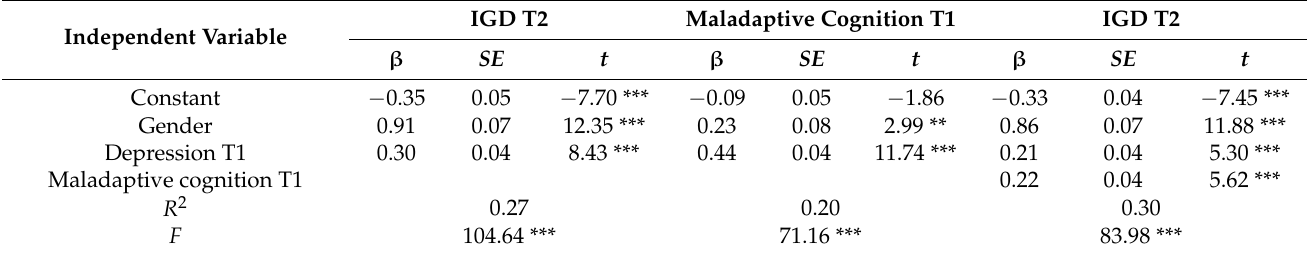
Table 2. Mediation Analysis.